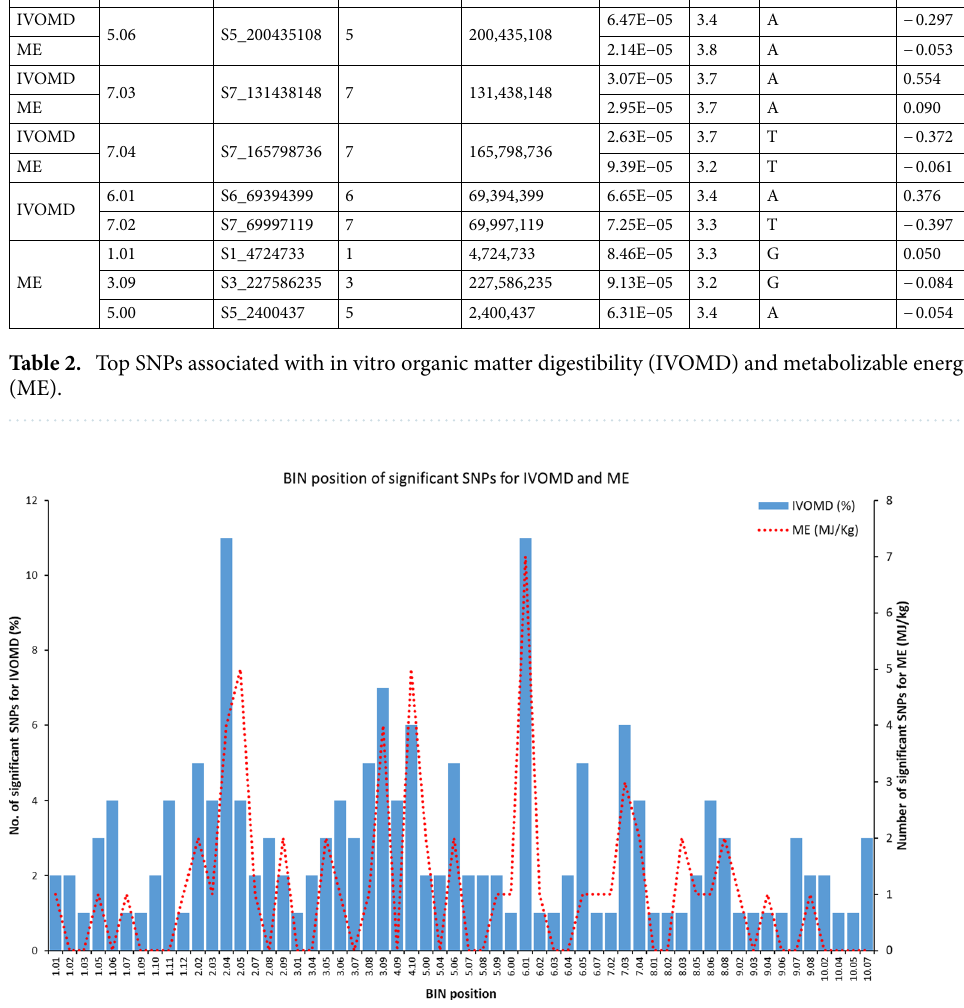
Figure 4. BIN positions for the identified significant SNPs for IVOMD (%) and ME